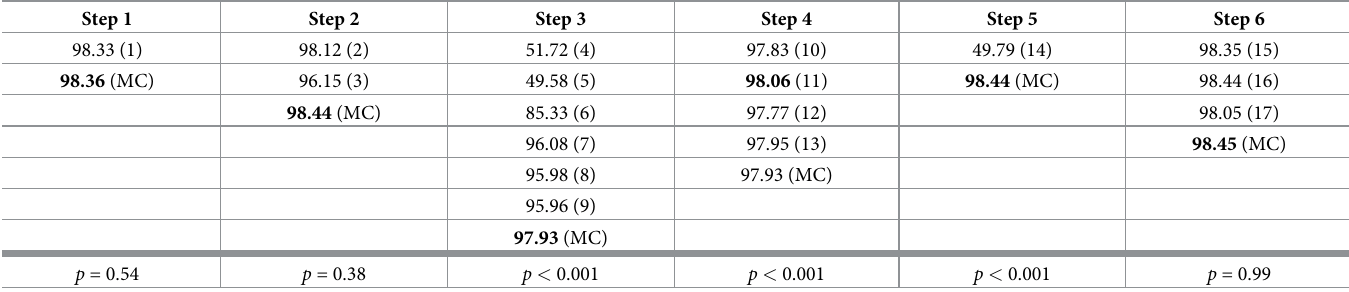
Table 5. Near-optimal chain identification results. For each processing step identified in Fig 3, the accuracy is reported (as a percentage). The number in the brackets indicates the processing chain in Table 2 from which that processing option was taken. The results in bold indicate the option selected for use in successive tests. Step 1 Step